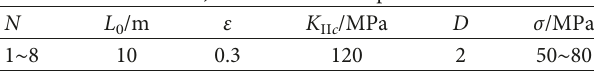
Figure 5: (a) Miaoziping Tunnel entrance. (b) Joints and fractures of the tunnel surrounding rock. Table 1: Jointed rock mass